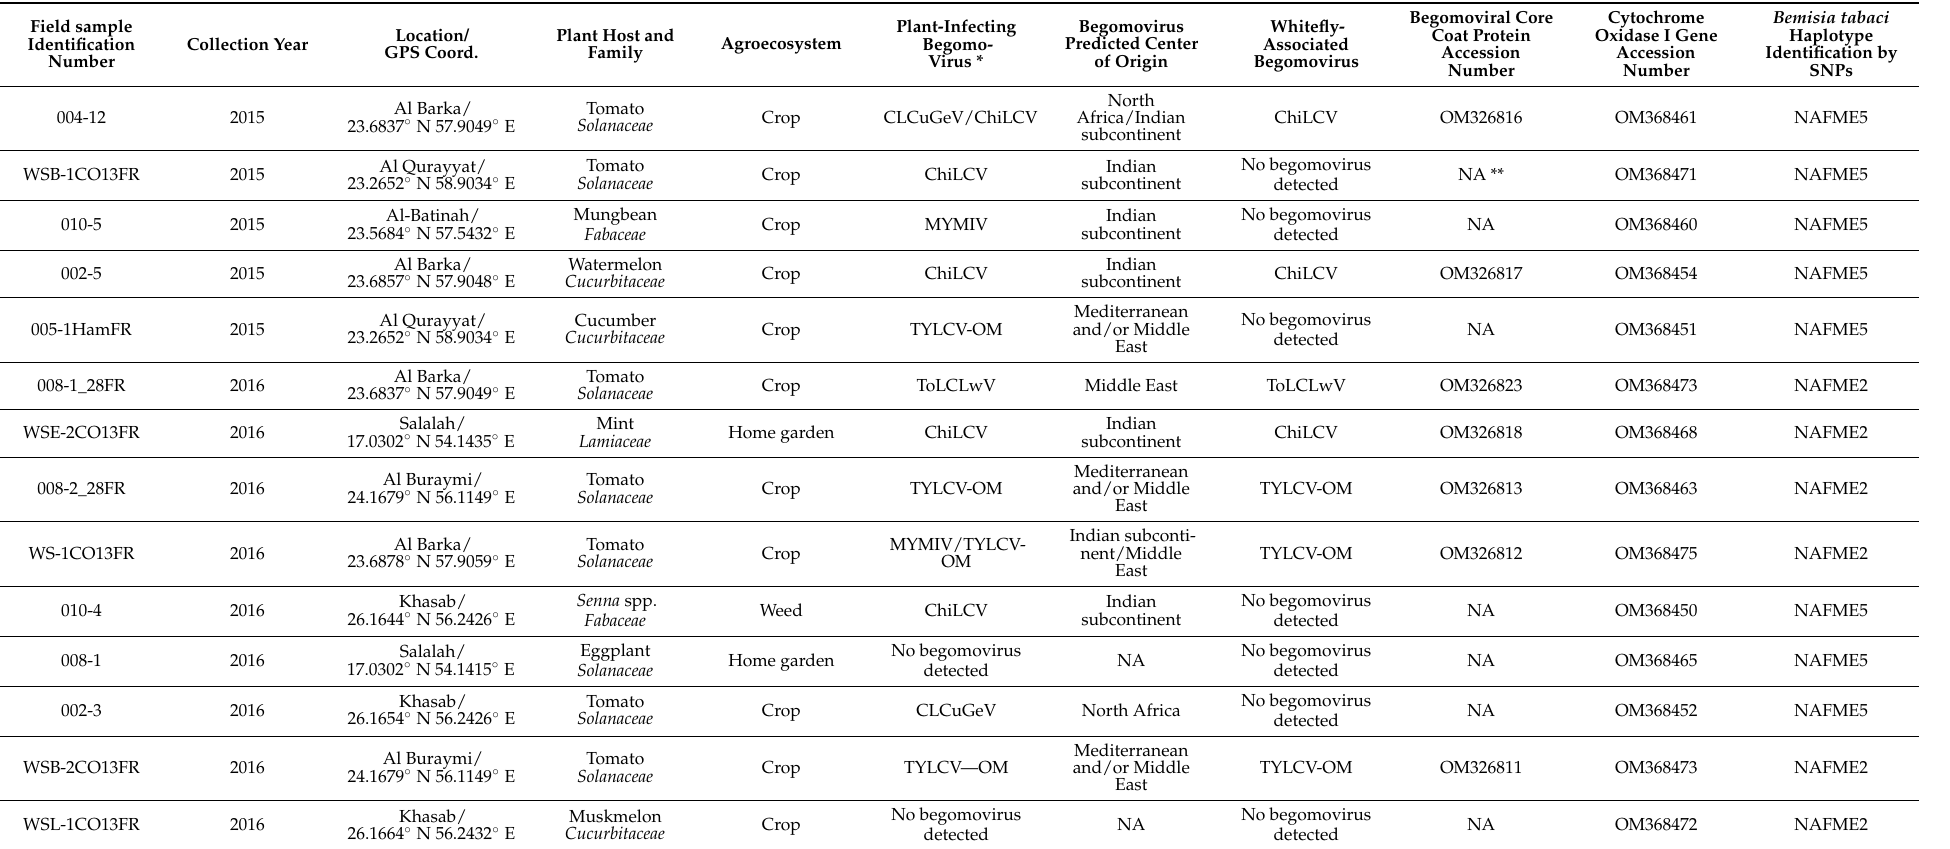
Table 1. Sample number, year of collection, location of collection with GPS coordinates, host plant, agroecosystem, provisional begomoviral species associated with plant and whitefly samples, begomoviral predicted center(s) of diversification, GenBank Accession number for begomoviral and mitochondrial cytochrome oxidase I (COI) sequence, and Bemisia tabaci haplotype based on SNPs